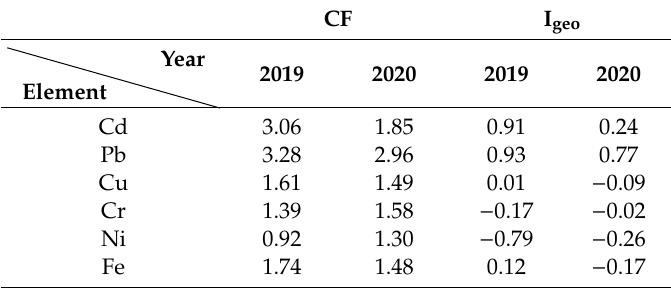
Table 4. Mean values of the contamination factor CF and Geo-accumulation Index I geo for the studied area. CF I geo